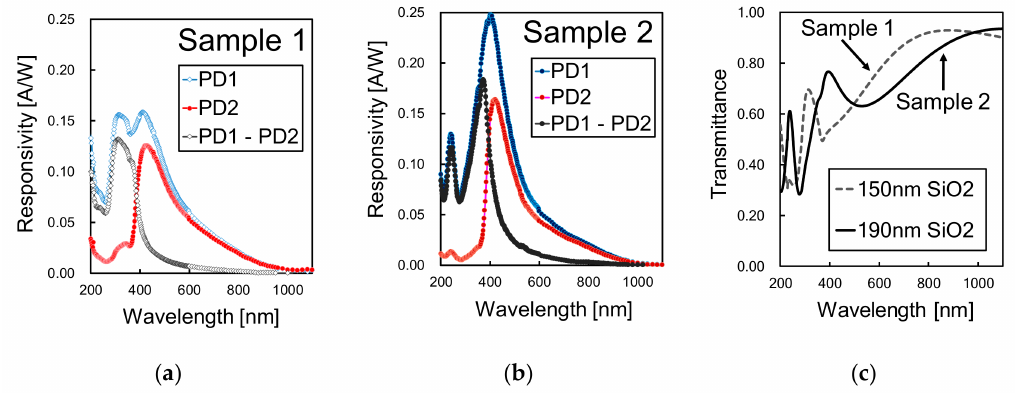
Figure 10. Measurement results of the spectral response for ( a ) Sample 1 and ( b ) Sample 2. ( c ) shows the calculated transmittance characteristics of the employed SiO 2 passivation layer in each